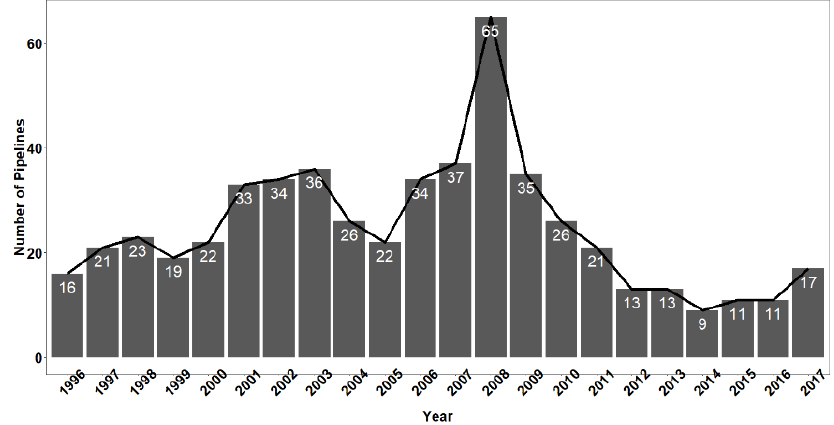
Figure 3. Frequency distribution for year of completion/put in service.